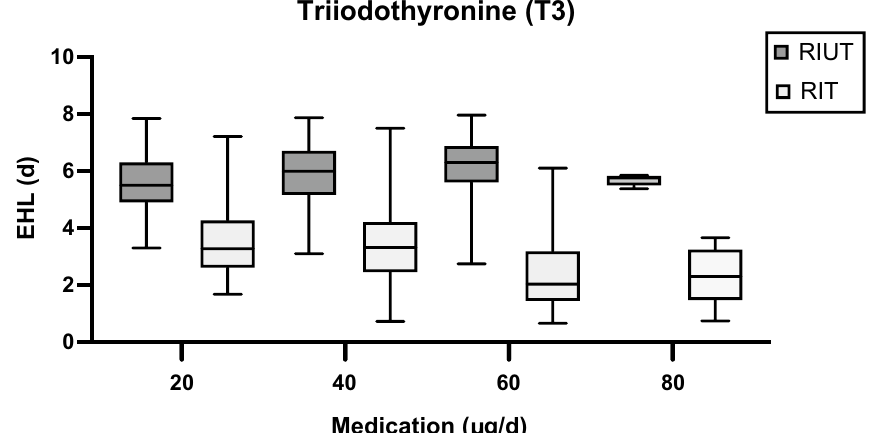
Figure 2. Development of pre- and intratherapeutic EHL depending on the dose of T3.